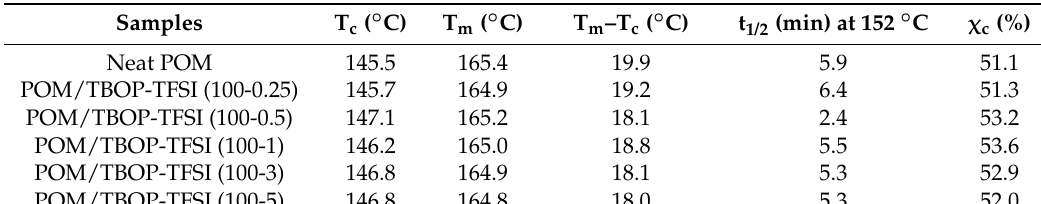
Differential scanning calorimetry (DSC) results of polyoxymethylene (POM)/ tributyl(octyl)phosphonium bis(trifloromethanesulfonyl) imide (TBOP-TFSI) composites. Samples